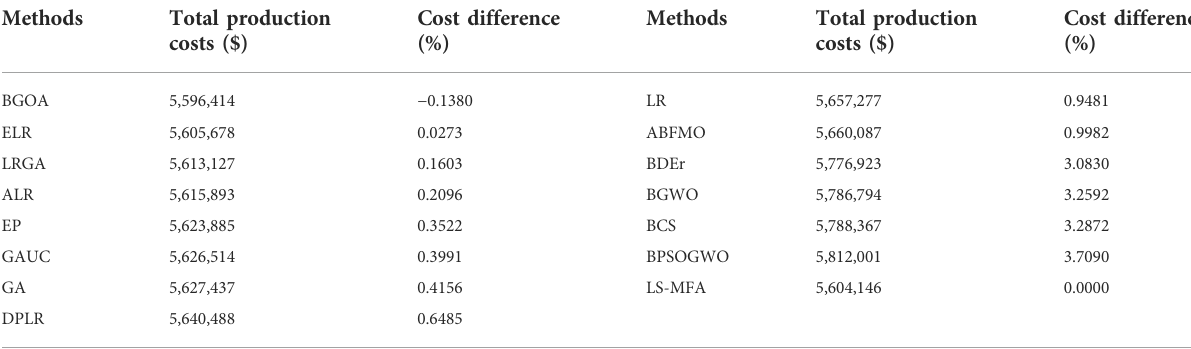
TABLE 10 Comparison of total cost with reported optimization techniques for 100-unit